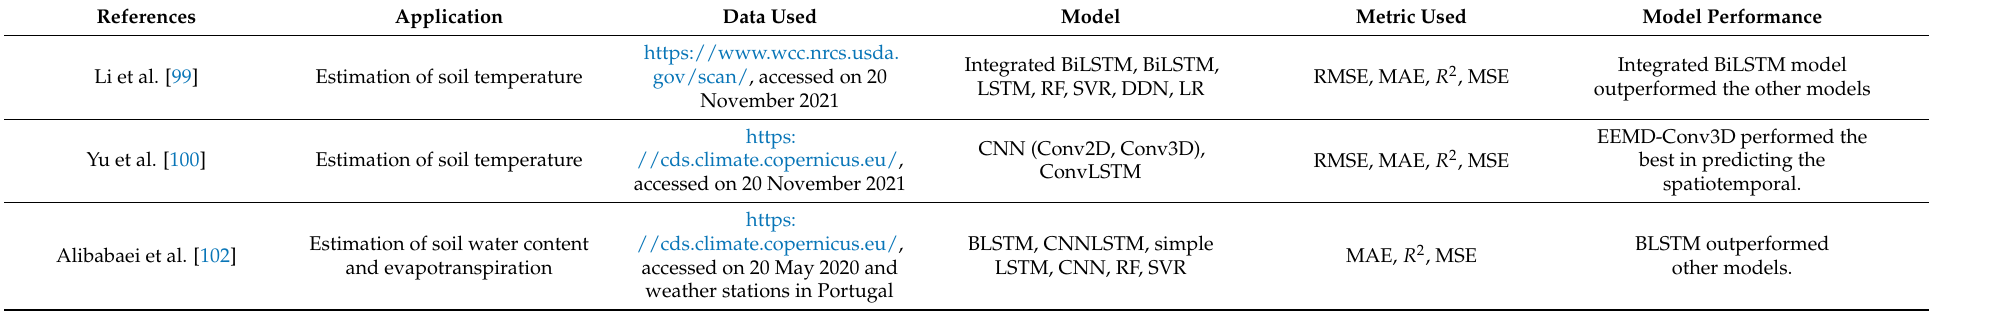
Table 7. Feature descriptions of recent published papers in the field of “Soil